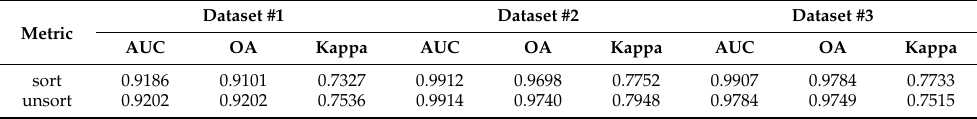
Table 7. Quantitative analysis of the SNLSW and NLSW on Datasets #1/2/3 with w 1 = 2, w 2 = 7.